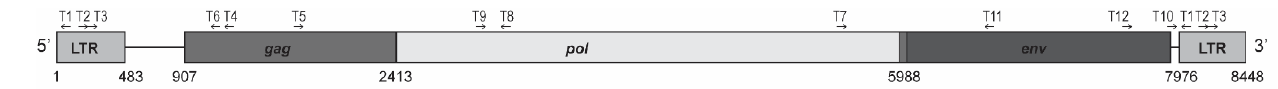
Figure 2. Locations of the 12 FeLV sgRNAs (T1 to T12) in the FeLV-A/Glasgow-1 genome (GenBank: KP728112.1). The three genes, gag (group-specific antigen), pol (polymerase), and env (envelope) are flanked by the LTRs (long terminal repeats). Three target DNA sequences were chosen in gag (T4–T6), pol (T7–T9), env (T10–T12), and LTR (T1–T3), each marked with an arrow. The size of the genes and the LTRs is proportional to the genome size; arrows mark the location of the target, but their size is not to scale. Numbers below the schematic of the genome represent the beginning and end of the LTRs, as well as the beginning of each gene.